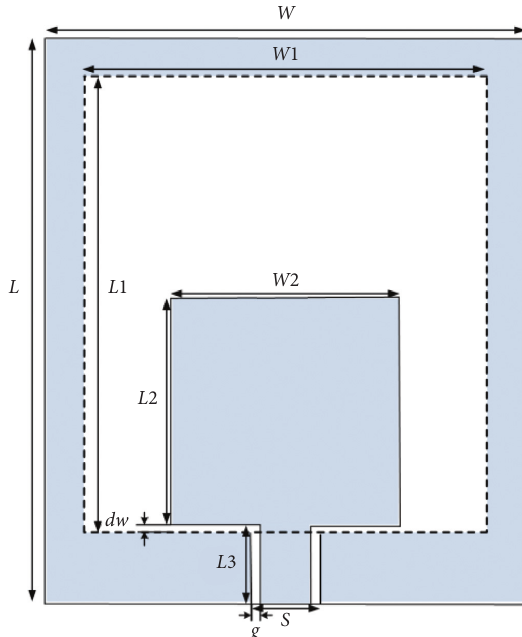
Figure 4: Schematic diagram of feature point selection.